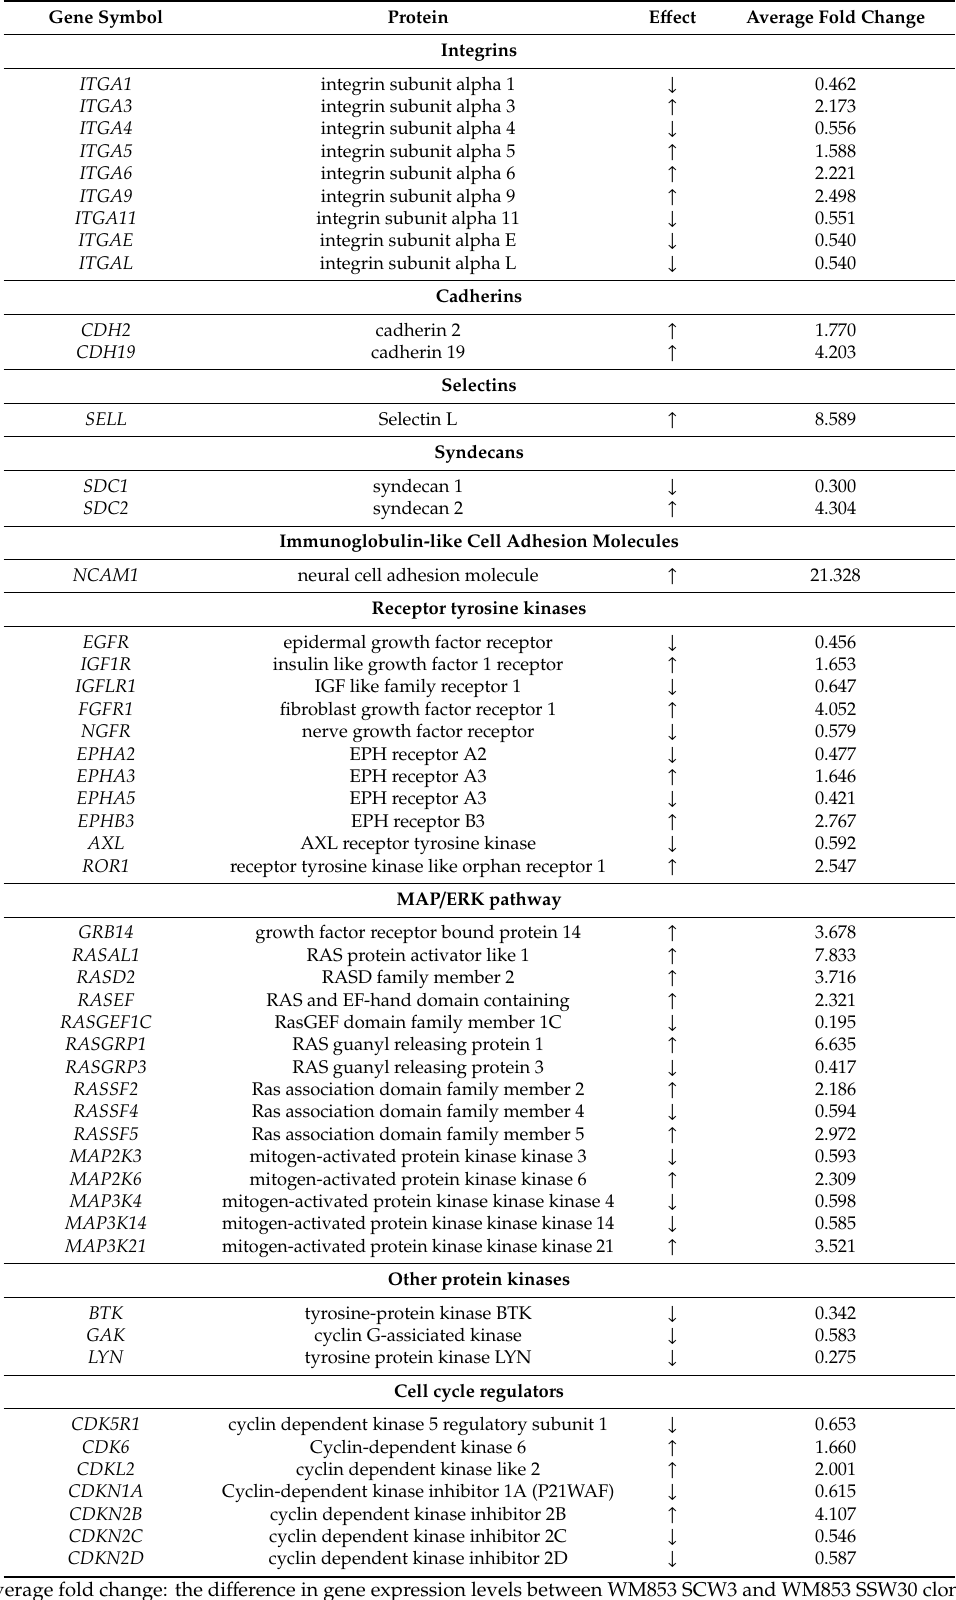
Table 1. Selected category of genes (based on a literature search) with changes in expression in WM853 cells with SIRT2 downregulation as determined using